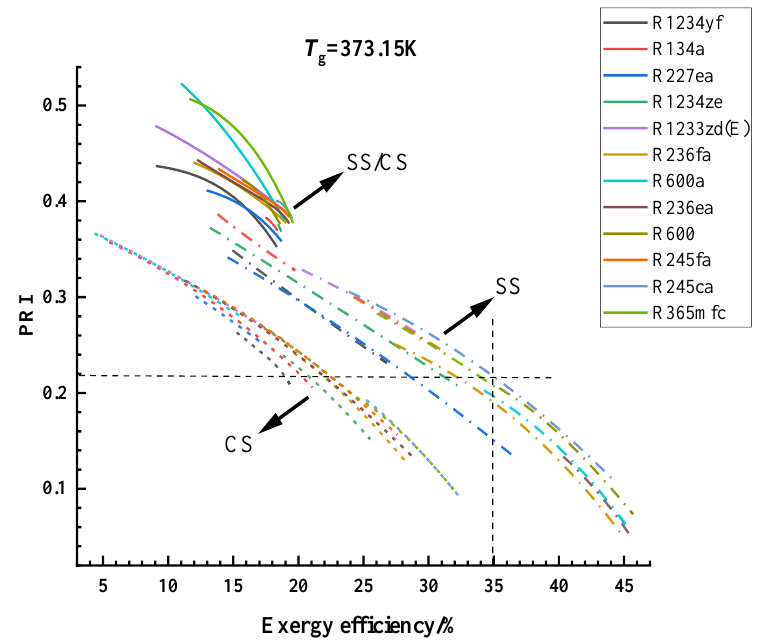
Figure 6. Optimized results under the heat source temperature of 373.15 K.